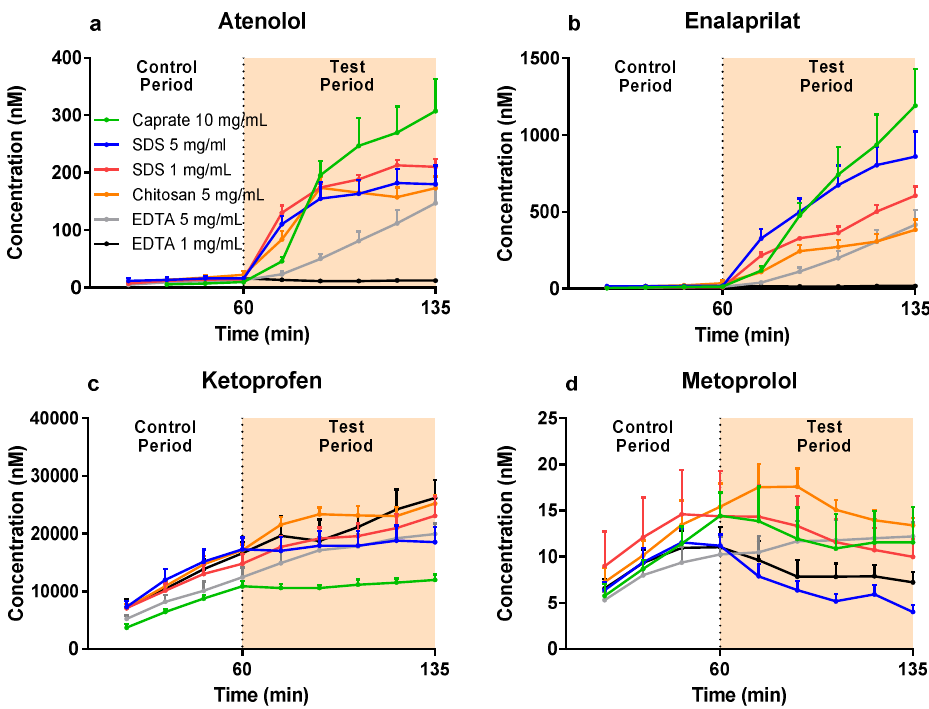
Figure 2. The mean ± SEM rat colonic plasma concentration–time profiles ( n = 6) of: ( a ) atenolol, ( b ) enalaprilat, ( c ) ketoprofen, and ( d ) metoprolol following single-pass intestinal perfusions of a control solution for 60 min, followed by a 75-min perfusion of any of six test formulations containing a permeation enhancer (PE). The control solution and all test formulations contained 100 µ M atenolol, enalaprilat, ketoprofen, and metoprolol. The control and test formulation perfusate pH was 6.5 for the PEs: sodium dodecyl sulfate (SDS) at 1 and 5 mg / mL, chitosan at 5 mg / mL, and ethylenediaminetetraacetic acid (EDTA) at 1 and 5 mg / mL. The control and test formulation perfusate pH was 7.4 for caprate at 10 mg / mL. All formulations were solutions, except caprate which was a suspension (its solubility at pH 7.4 is 5 mg / mL). Table 2. The mean ± SD rat permeability (P e ff ) values for the four model compounds determined in the jejunum and colon at pH 6.5 and 7.4 ( n =